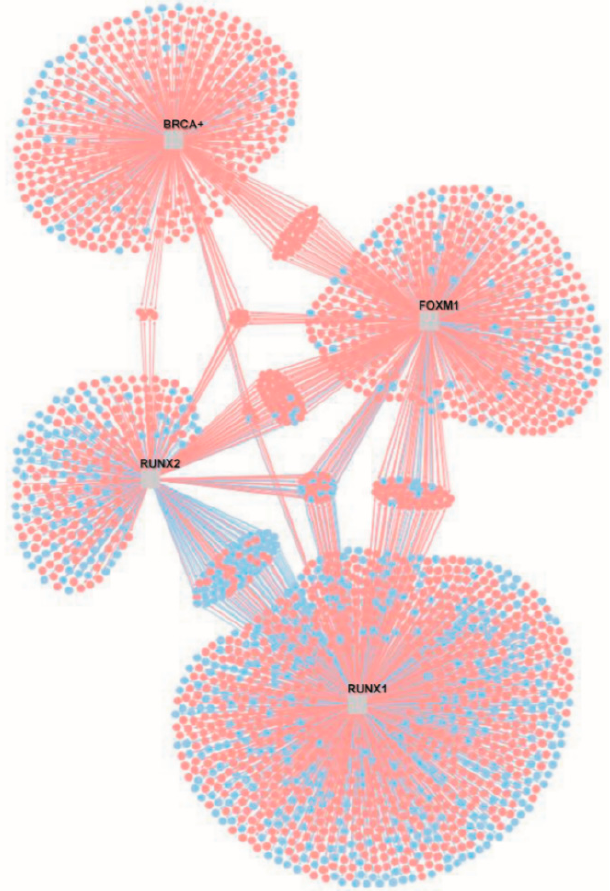
Figure 3. Transcriptional regulatory network of RUNX2 and its coregulators BRCA1, FOXM1, and RUNX1 (gray squares). In blue are the downregulated targets, and in red are the upregulated